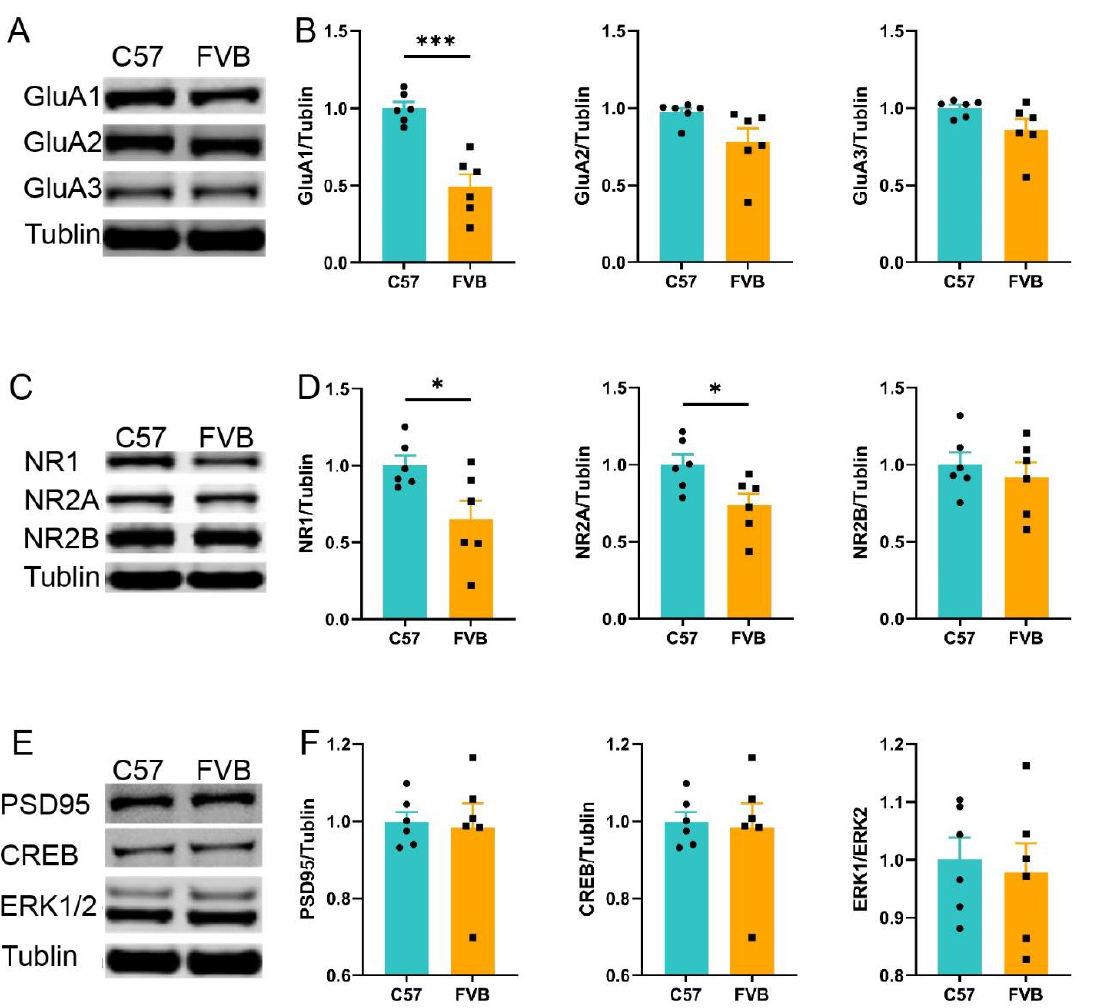
Figure 3. FVB mice showed a decrease in AMPAS and NMDARs compared with C57 mice. ( A ). Western blot analysis of AMPAs in hippocampal protein content between C57 and FVB mice. ( B ). Relative protein content level of AMPAs ( left : GluA1, middle : GluA2, right : GluA3; n = 6, t -test). ( C ). Western blot analysis of NMDARs in hippocampal protein content between C57 and FVB mice. ( D ). Relative protein content level of NMDARs ( left : NR1, middle : NR2A, right : NR2B; n = 6; t -test). ( E ). Western blot analysis of other protein contents in the hippocampus between C57 and FVB mice (n = 6). ( F ). Relative protein content levels of ERK ( left ), CREB ( middle ), and PSD95 ( right ). * p < 0.05, *** p < 0.001, Mean ± SEM.